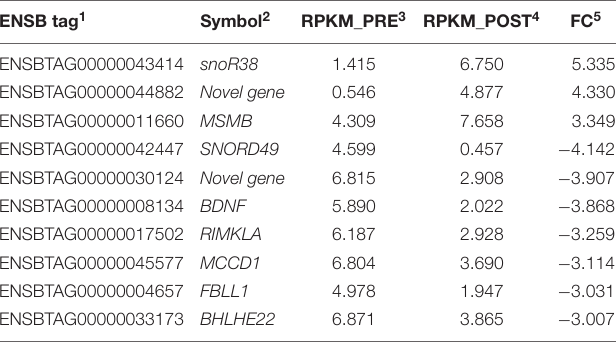
TABLE 1 | The reads per kilobase per million (RPKM) mapped read values for genes that significantly differ in expression in liver between pre- vs. post-pubertal Brahman heifers (|FC| ≥ 3, P ≤